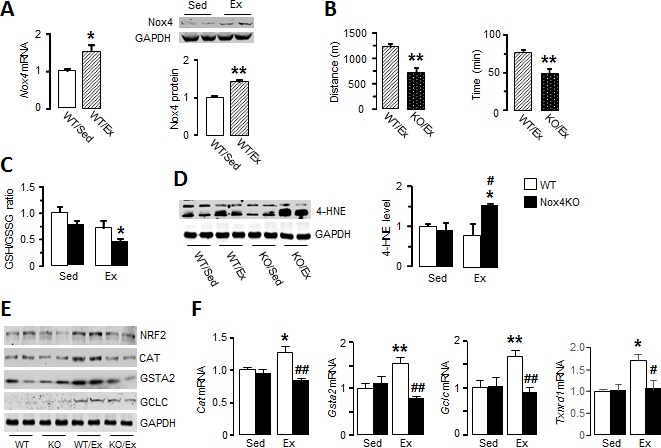
Nox4 mediates myocardial Nrf2 activation and is essential in the acute response to exercise.(A) Changes in myocardial Nox4 mRNA and protein levels after acute moderate exercise (Ex) compared to sedentary controls (Sed). *p<0.05, **p<0.01, 2-tailed t-test (n = 4–6/group). (B) Exercise capacity of Nox4-null mice (Nox4KO) and littermate wild-types (WT) measured by maximal running distance and running time. **p<0.01, 2-tailed t-test (n = 5–8/group). (C) Ratio of glutathione/glutathione disulfide (GSH/GSSG) in Nox4KO and WT mouse hearts before (Sed) and after exercise (Ex). n = 6–9/group. (D) Protein levels of 4-hydroxynonenal (4-HNE) adducts in the heart. n = 3–4/group. (E and F) Protein and mRNA levels of major Nrf2 targets. n = 3–6/group *p<0.05, **p<0.01 vs respective sedentary controls (Sed); #p<0.05, ##p<0.01 vs WT/Ex, 1-way ANOVA followed by Tukey post hoc analysis. CAT: catalase, GSTA2: glutathione S-transferase A2, GCLC: glutamate cysteine ligase catalytic subunit, TXNRD1: thioredoxin reductase 1.